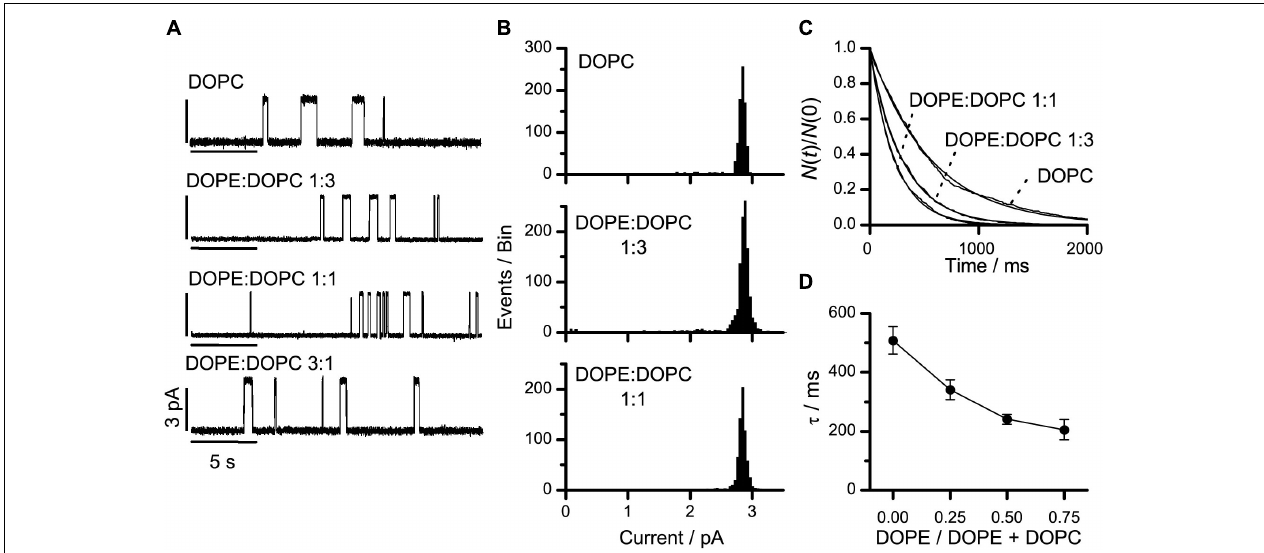
FIGURE 3 | VgA(15) channel function in DOPE:DOPC/ n -decane bilayers. (A) Current traces of VgA(15) channels in DOPE:DOPC/ n -decane bilayers at different DOPE:DOPC molar ratios in the bilayer-forming solution. (B) Current transition amplitude histograms in DOPC and DOPE:DOPC (1:3 or 1:1) bilayers (results from single experiments). (C) Normalized single-channel duration histograms in DOPC ( τ = 563 ms), DOPE:DOPC (1:3) ( τ = 304 ms) or DOPE:DOPC (1:1) ( τ = 229 ms) bilayers. Results from single experiments fitted by single exponential distributions. (D) Relation between DOPE/(DOPE + DOPC) and τ (mean ± SD, n ≥ 3). 1.0 M NaCl, 200 mV, 100